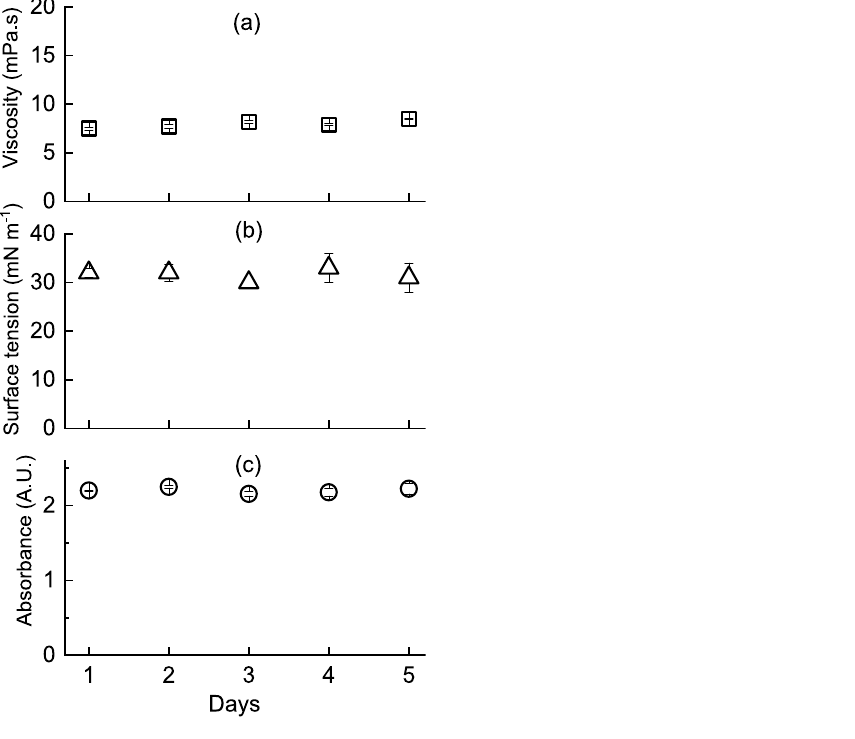
Figure 5. Stability of ink ( a ) viscosity ( □ ), ( b ) surface tension (∆) and ( c ) absorbance at 280 nm (Ο) over time.